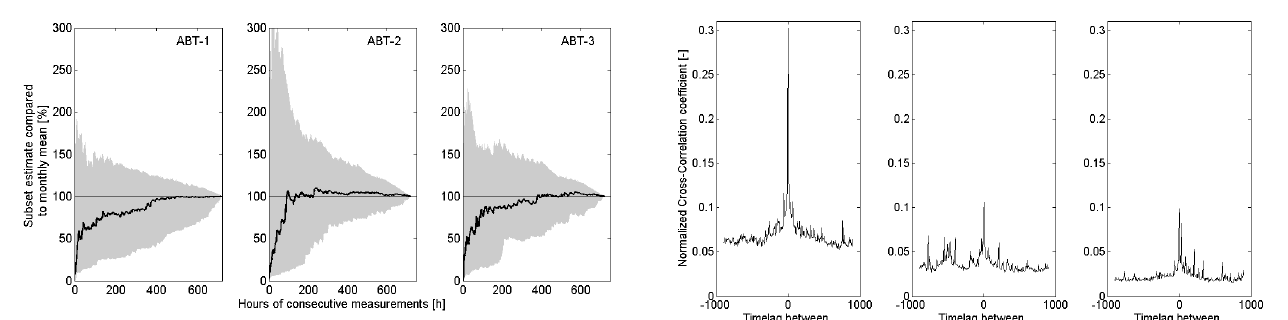
Fig. 6: Mean ebullition rates averaged over subsets of varying length representing consecutive measurement periods normalized by the mean ebullition rate observed over a 30-day period centered around the respective subset for the automated bubble traps (ABT 1 to 3) (left to right). The black line shows the median of all subsets and the grey area denotes the 10th and 90th percentiles.